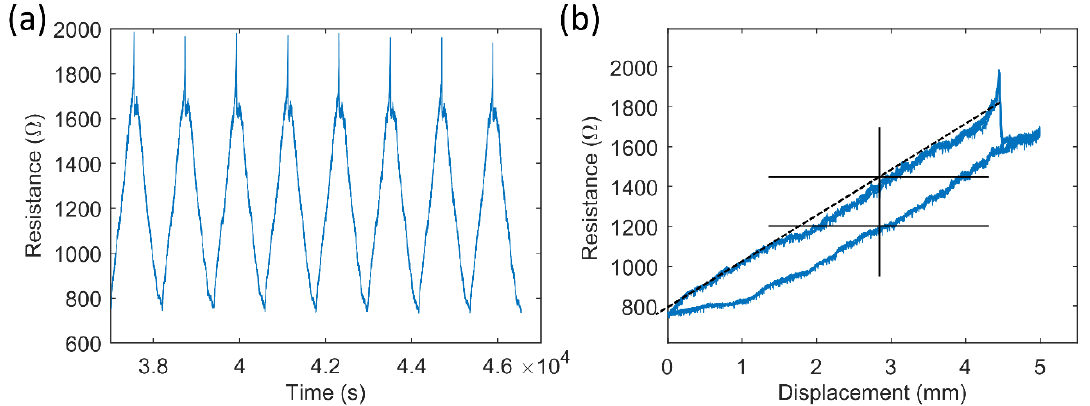
Figure 9. Sensor properties of tested cyclic test samples (153- µ m-thick CFC, 10,000 cycles, 50% elongation, 240 mm/min speed). ( a ) Raw data with 10% elongation and 0.5 mm/min speed, and ( b ) a resistance ‐ displacement curve of the first 4 cycles from ( a ).